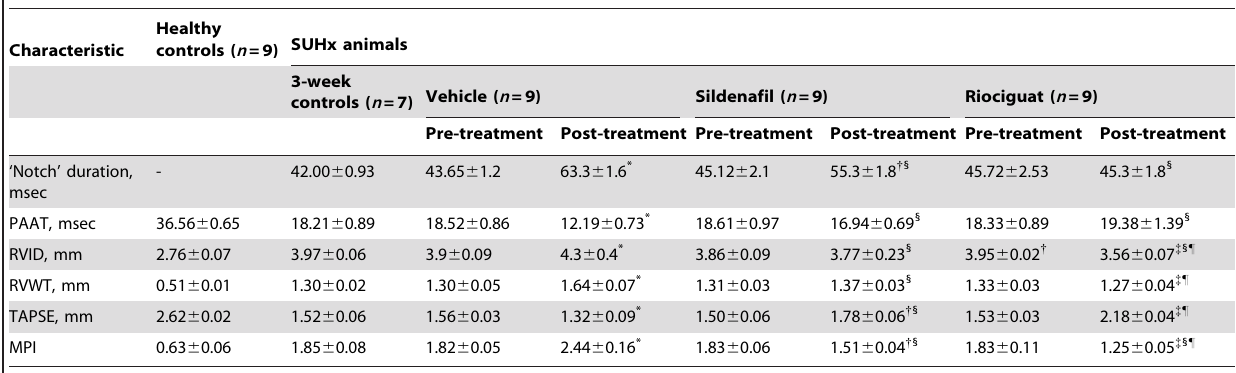
Table 1. Baseline and post-treatment characteristics of the studied groups.